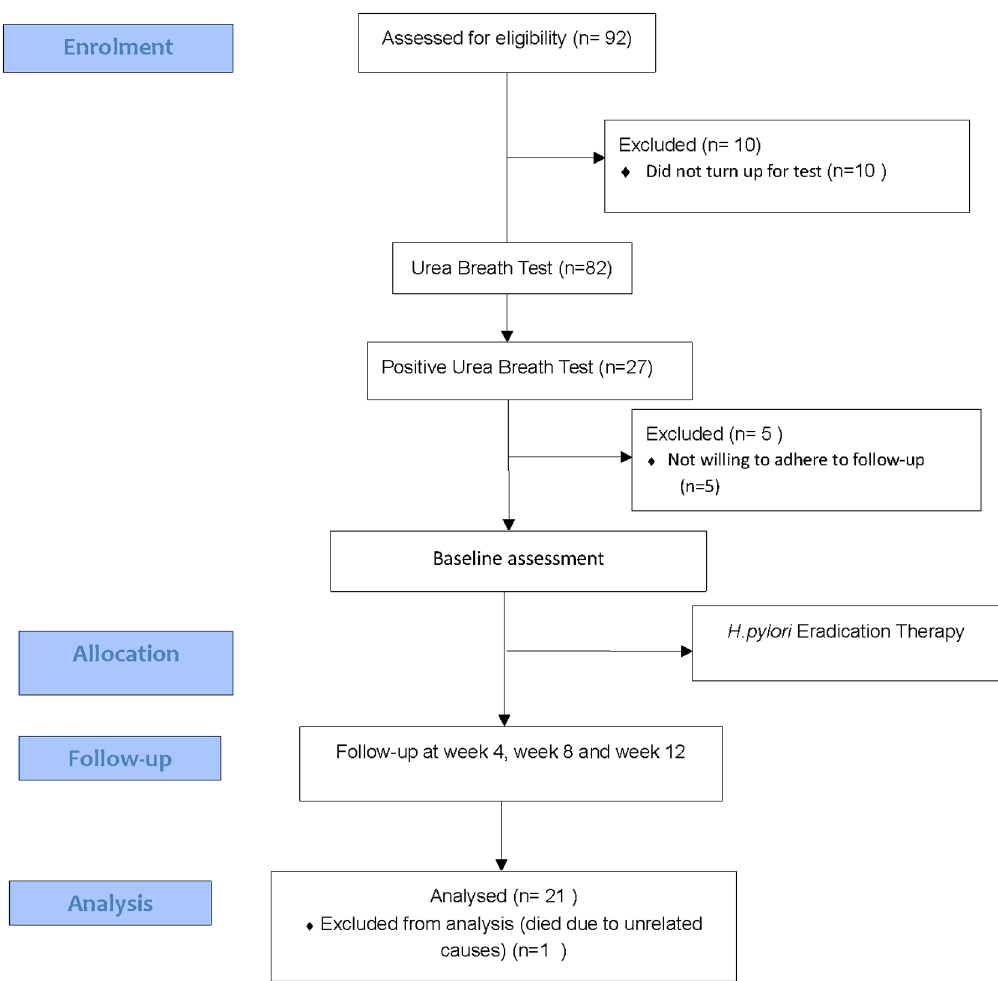
Figure 1. Study Flow Chart.